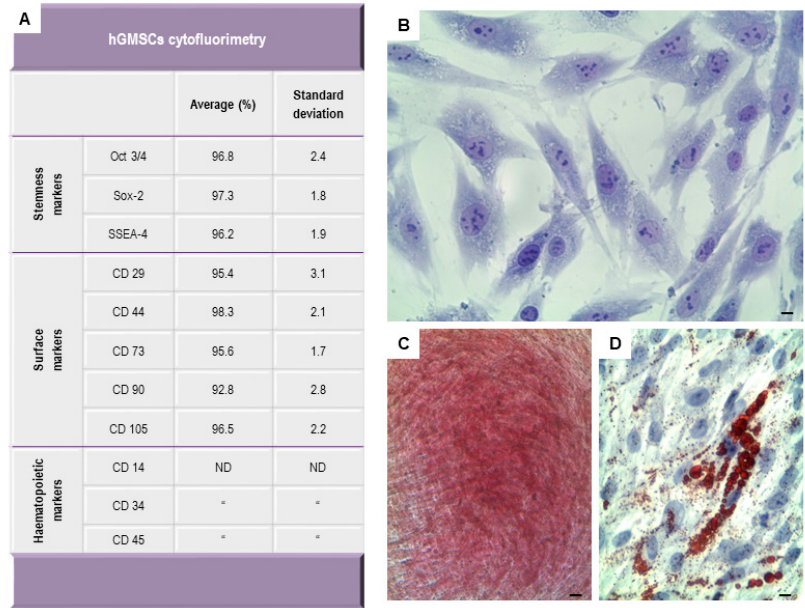
Figure 1. Human gingival mesenchymal stem cells (hGMSCs) characterization. ( A ) flow cytometry showed the positivity expression of Oct3/4, Sox-2, SSEA-4, CD29, CD44, CD73, CD90 and CD105. hGMSCs stained with toluidine blue solution; ( C ) hGMSCs under osteogenic differentiation conditions stained with alizarin red S solution; ( D ) hGMSCs stained with Adipo Oil red to demonstrate adipogenic